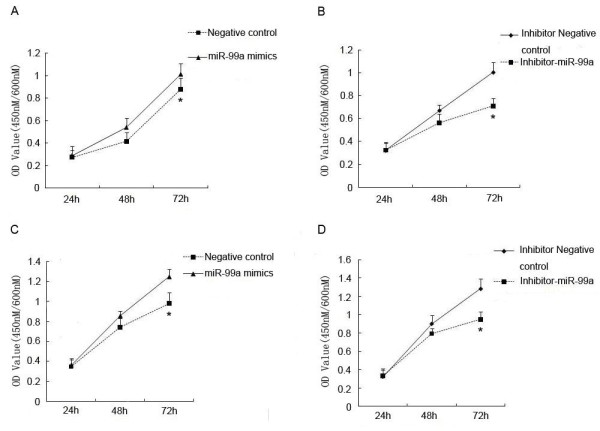
MiR-99a promotes the proliferation of HL60 and K562 cells. HL60 and K562 cells were transfected with miR-99a mimics, inhibitor-miR-99a or corresponding negative control respectively. MTT assay shows miR-99a significantly promotes the proliferation of the HL60 (A) and K562 (C) cells, and inhibitor-miR-99a reduces the proliferation of the HL60 (B) and K562 (D) cells. *P < 0.05.